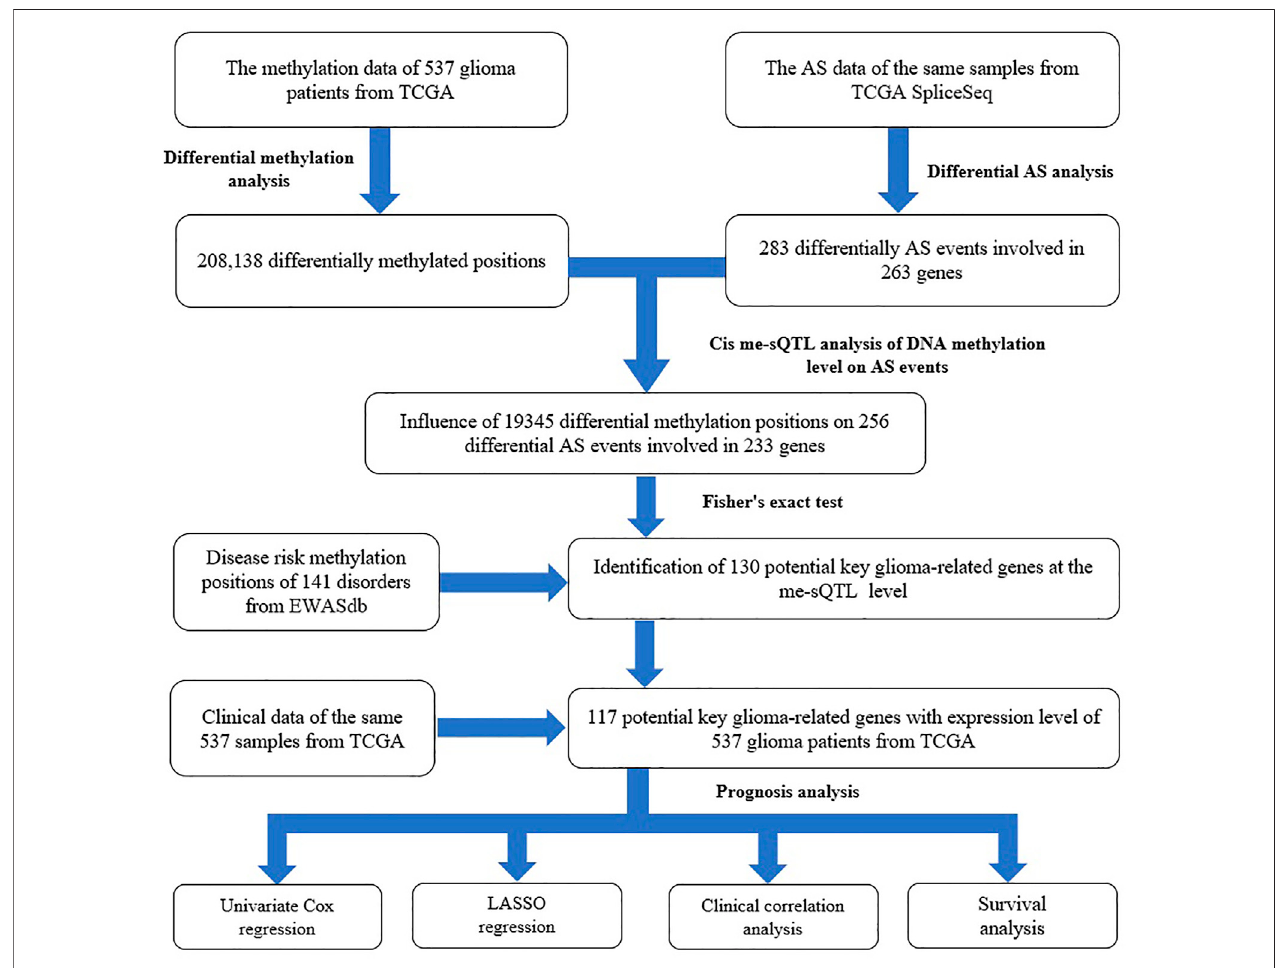
FIGURE 1 | The fl ow chart of the study design for exploring the in fl uence of DNA methylation level on gene AS in glioma and its impact on disease prognosis.